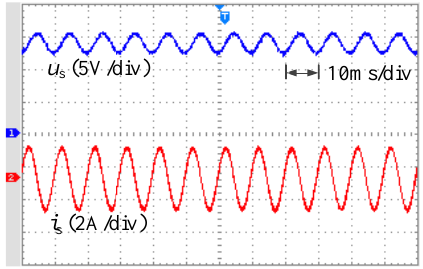
Figure 21. The power decoupling capacitor C s voltage u s and current i s .